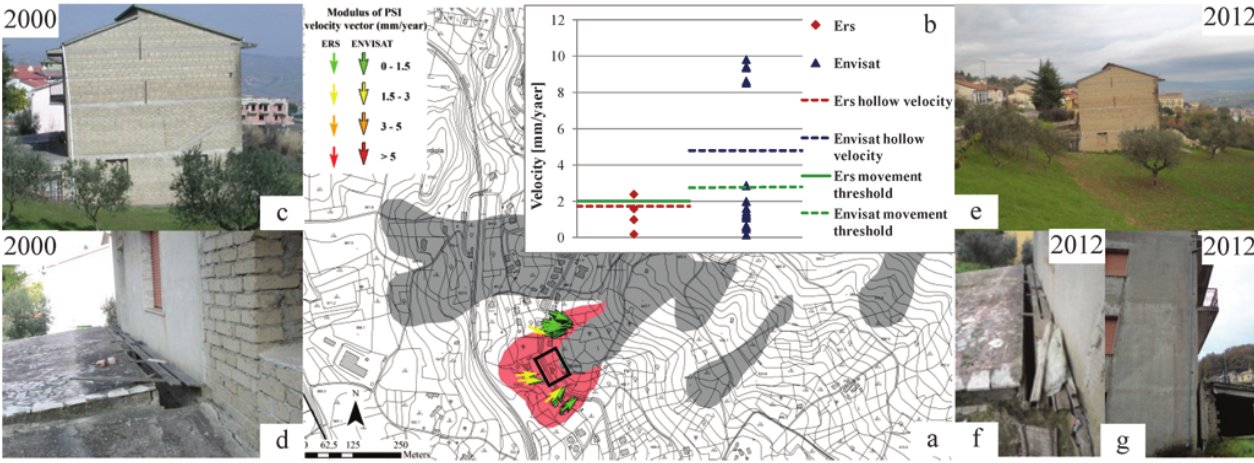
Fig. 26. A hollow located in the municipality of Campolattaro (Benevento Province): (a) map the hollow (in red) located at the head of a rotational slide-earth flow (in gray) with ERS/ENVISAT PS velocity vectors; (b) diagrams of the ERS/ENVISAT velocity values for the PS located within the hollow boundaries and indication of both the computed hollow velocity and the movement threshold; tilting of a masonry building and highlights on the crack pattern recorded during the surveys of 2000 (c–d) and 2012 (e–g)